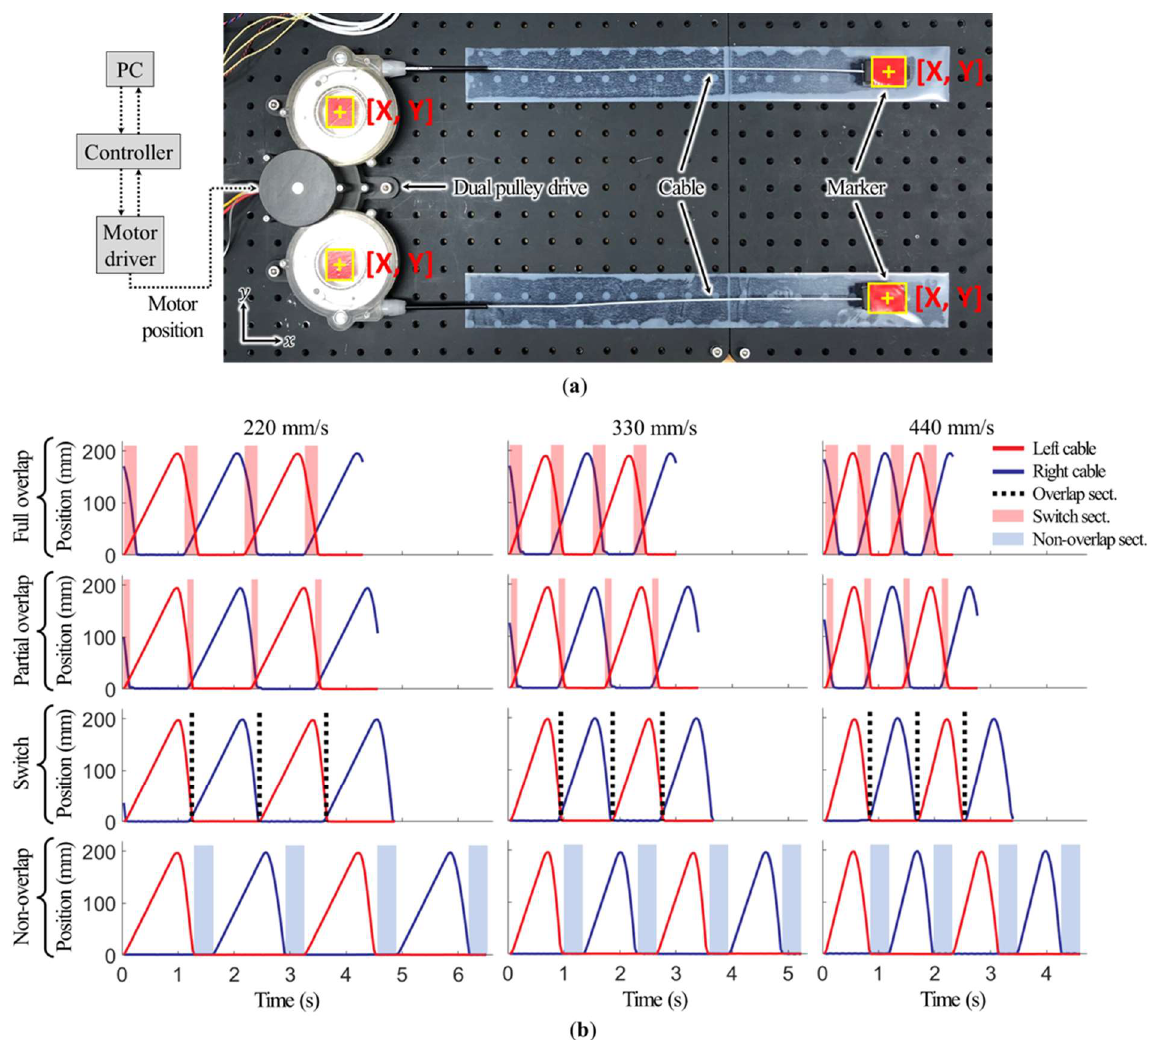
Figure 8. Cable position profile test: ( a ) test bench for marker tracking; ( b ) test result profiles.